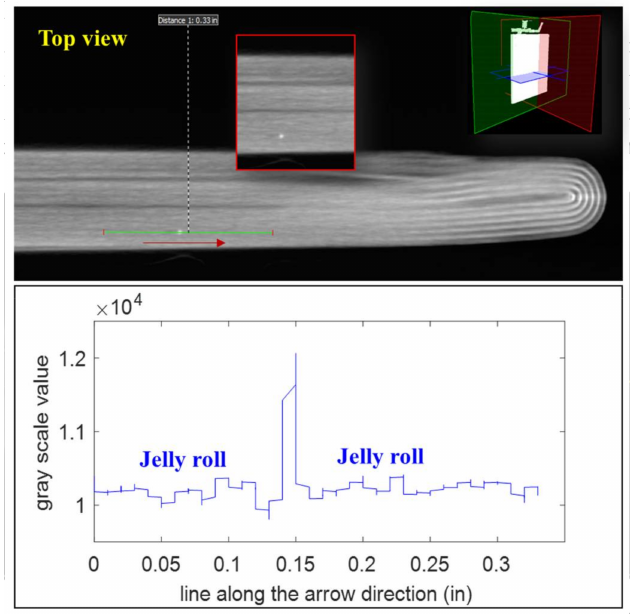
Figure 22. The point of interest in the battery from the used sample and the gray-scale profile along the marked green line crossing the